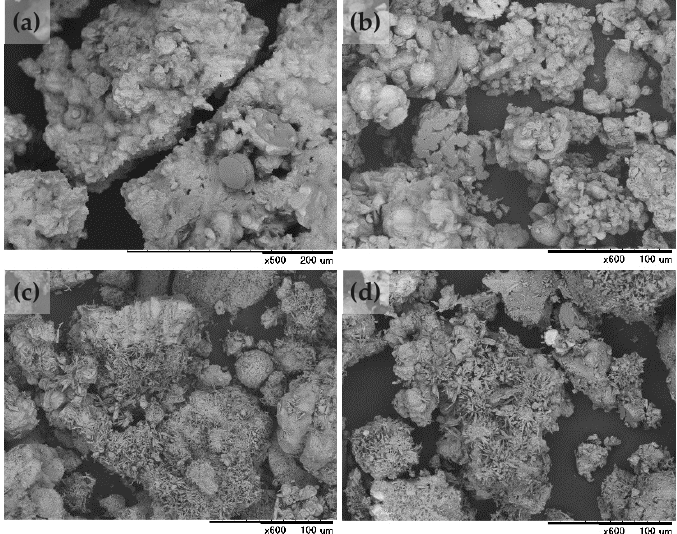
Figure 11. Scanning electron microscopy (SEM) images of microbial induced precipitate by Sporosarcina sp. with ( a ) Mg 2+ /Ca 2+ = 0.00; ( b ) Mg 2+ /Ca 2+ = 0.25; ( c ) Mg 2+ /Ca 2+ = 0.43; ( d ) Mg 2+ /Ca 2+ = 1.00.